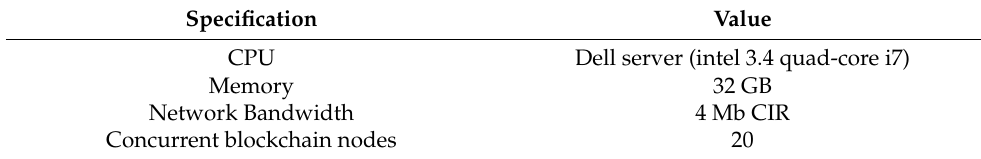
Table 1. Specification of the environment.